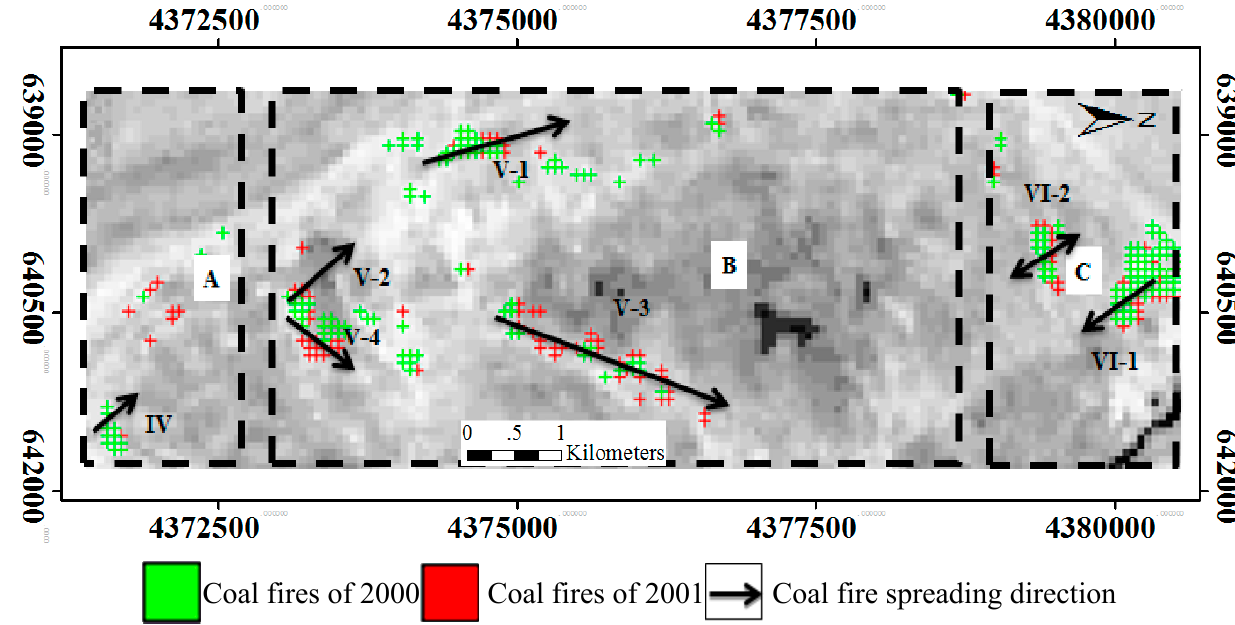
Figure 10. Coal fire map from 1999 to 2000. The results of the coal fires of 1999 and 2000 were stacked for the overlay analysis, and the coal fire spreading directions were also delineated as shown in this image with the 1999 ETM+ TIR band 6 data as the base map. According to the spatial distribution of the coal fires, we divided the entire study area into three main regions of coal fires.